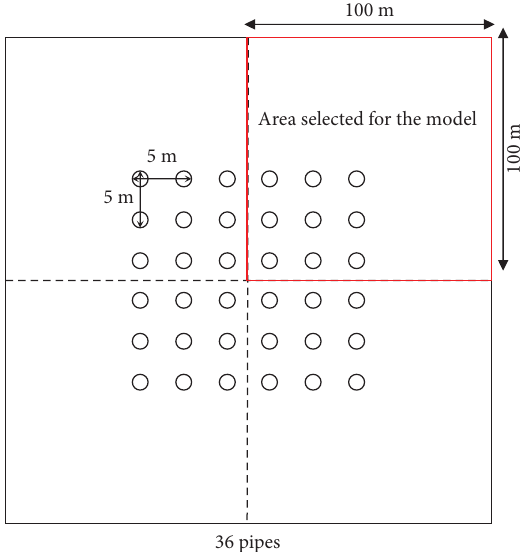
Figure 6: Te whole and the selected geometry for the numerical simulation